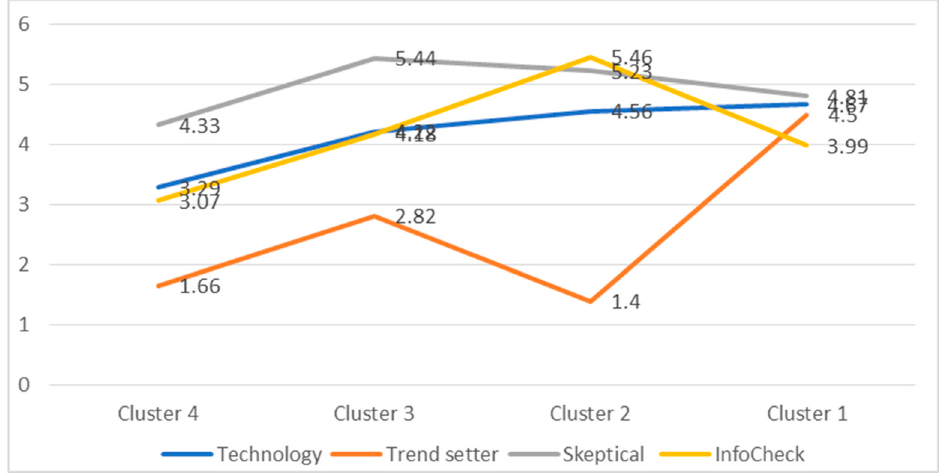
Figure 1. Average factor values for the 4 determined clusters.